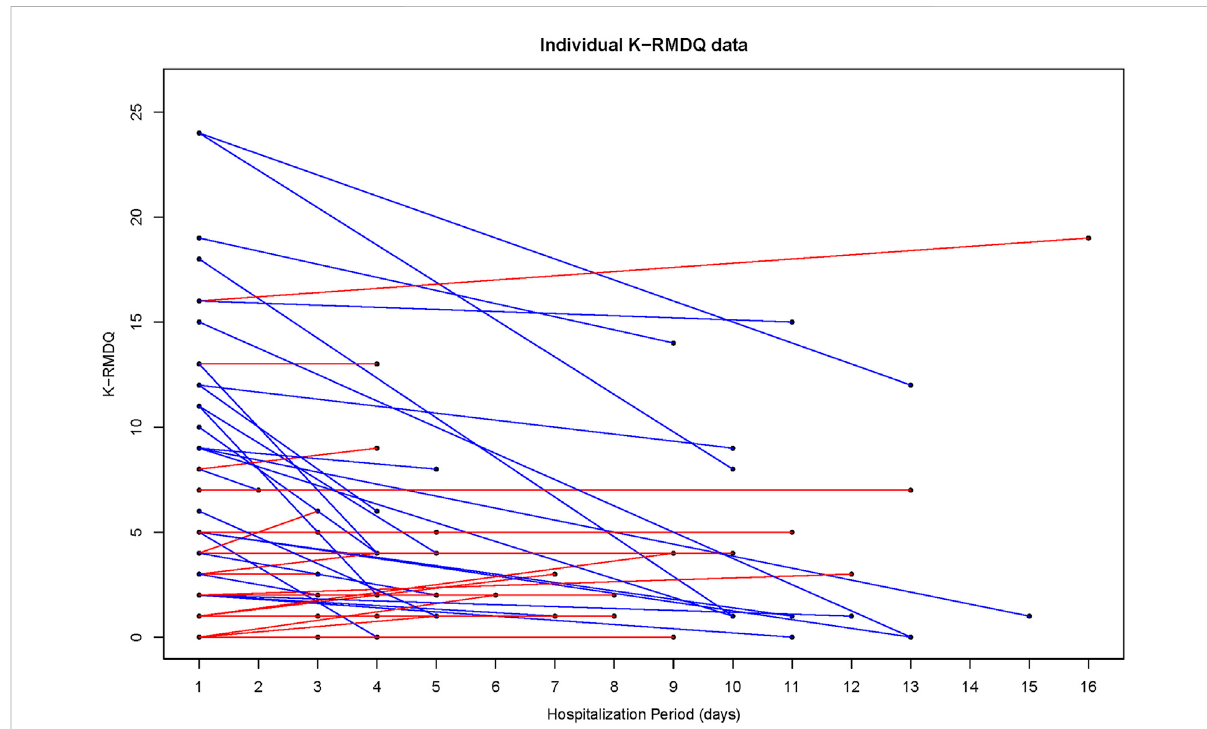
FIGURE 4 Individual Data of the Korean version of the Roland-Morris Disability Questionnaire